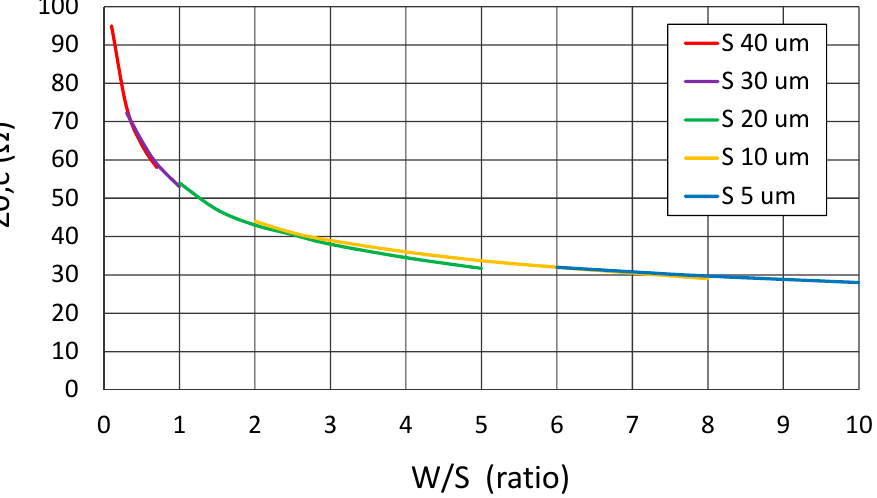
Figure 6. Characteristic impedance vs. W / S ratio for a GaAs or InP grounded coplanar waveguide (GCPW) line at millimeter-wave frequencies.